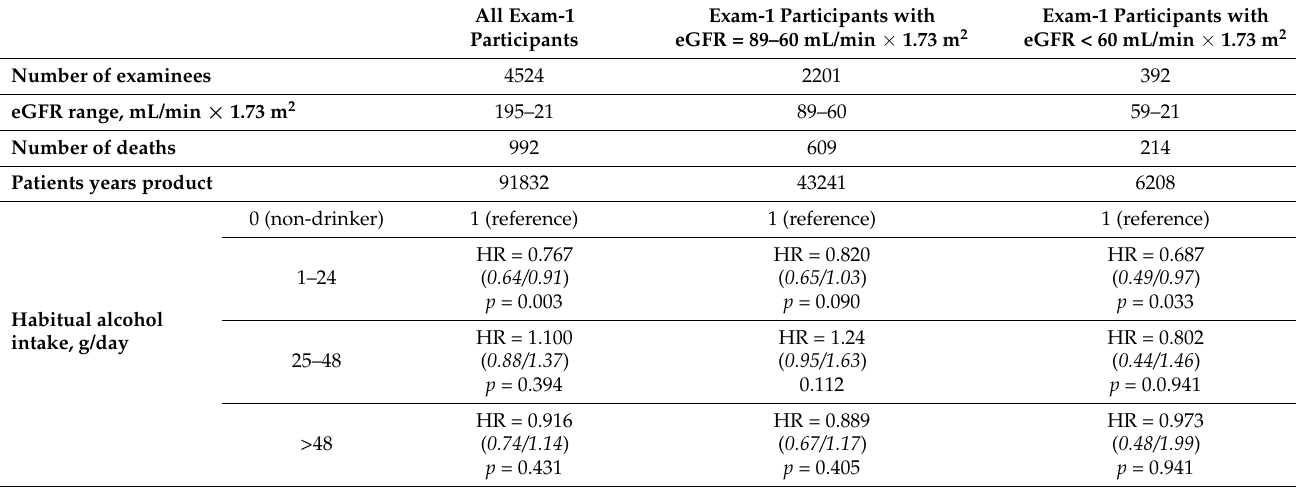
Table 5. Analysis of mortality: multi-variable Cox regression models with mortality rate during follow-up, regressed over stratum of alcohol intake and covariates at Exam-1, in all examinees with complete data and subgroups with decreased